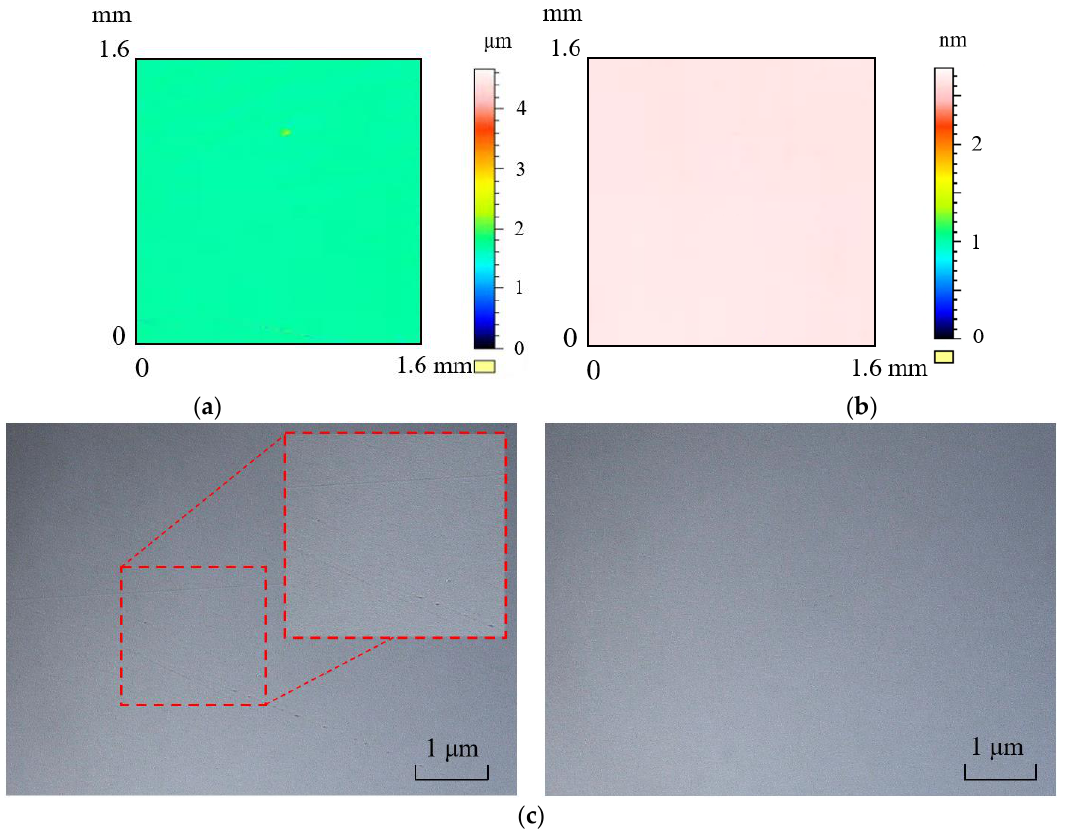
Figure 8. Variation in surface topographies: ( a ) initial, ( b ) 60 min polishing, and ( c ) actual topography of the workpiece before ( left ) and after ( right )